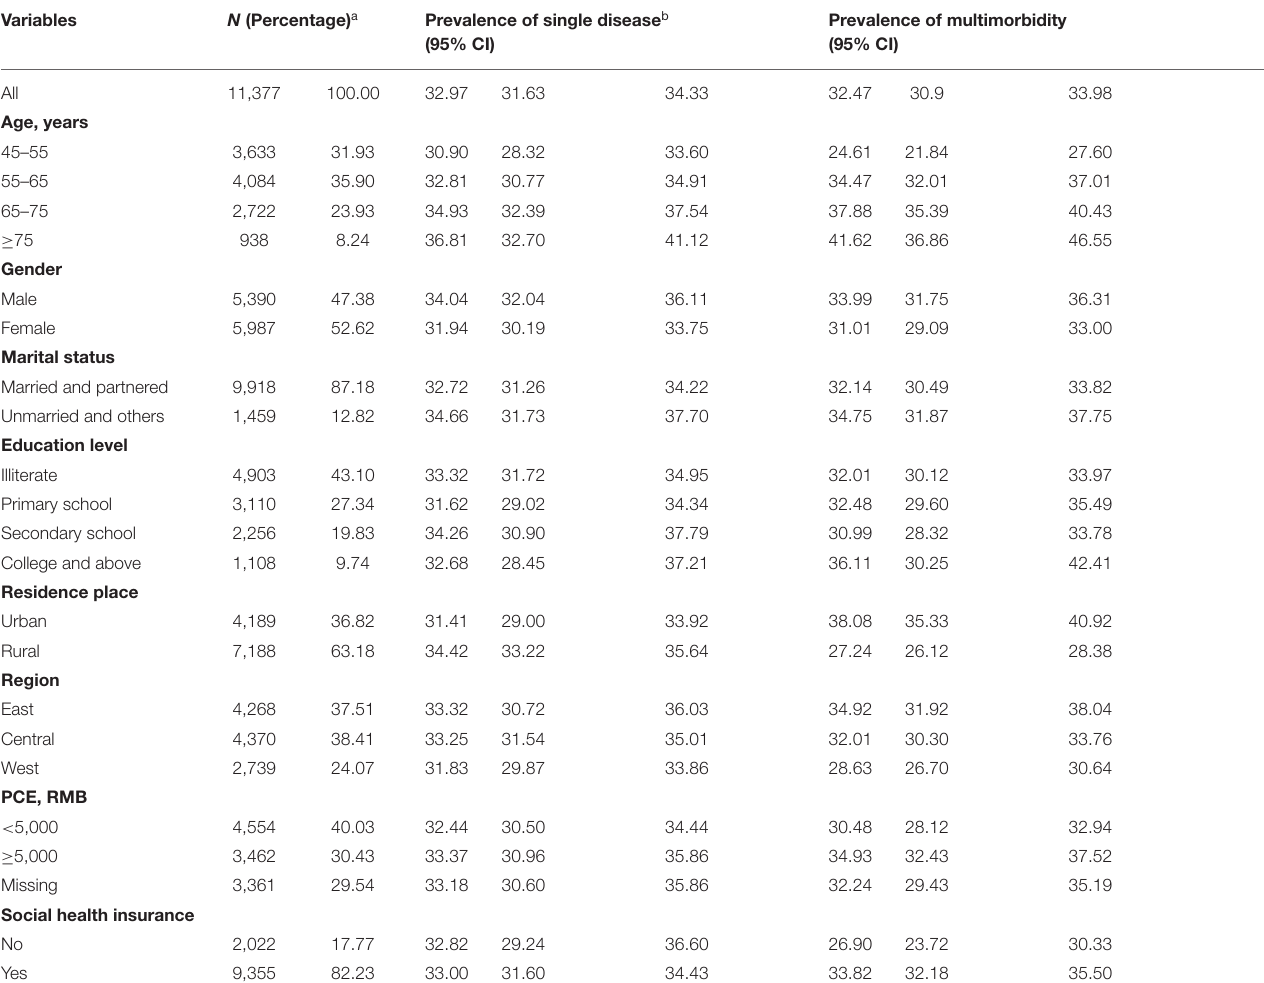
TABLE 1 | Characteristics of participants, the prevalence of single condition, and metabolic